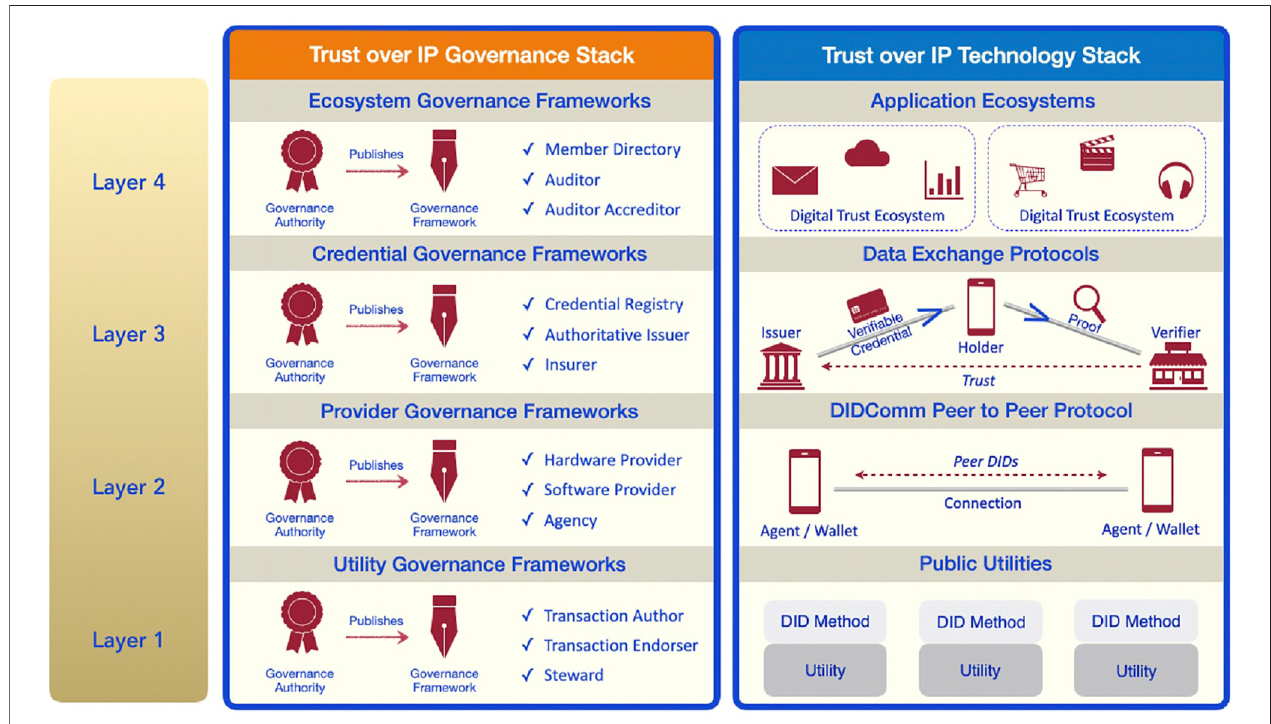
FIGURE 1 | Architecture of the Trust over IP (ToIP) stack. (Source: Trust over IP Foundation